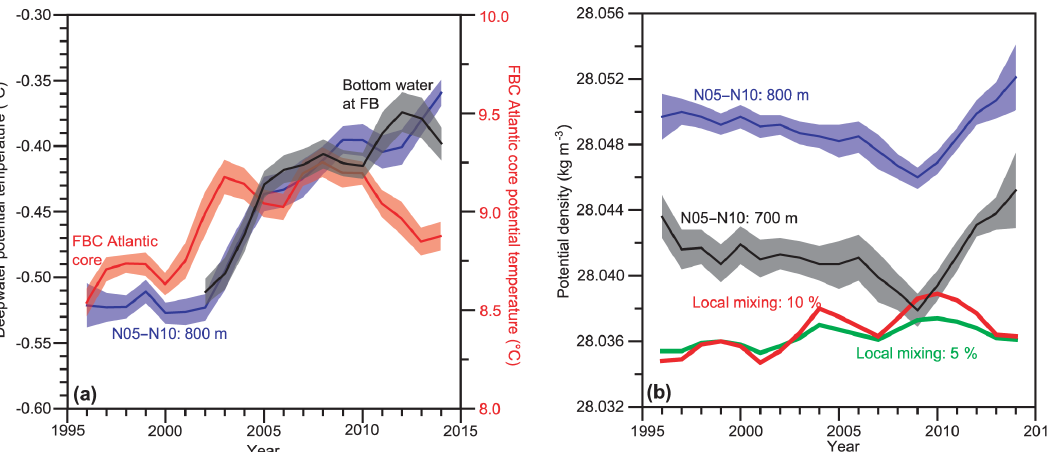
Figure 8. (a) Potential temperature of the Atlantic water core on section V (red, right axis), of the bottom water at FB (black, left axis), and at 800m depth on section N (average of stations N05 to N10, blue, left axis). (b) Potential density at two fixed depths (black: 700m and blue: 800m) on section N (average of the six stations N05 to N10) and for the overflow layer assuming two different fractions of locally admixed Atlantic core water (green: 5% and red: 10%); see text. All curves are 3-year-running means with shaded areas representing average ± 1 standard error over each 3-year